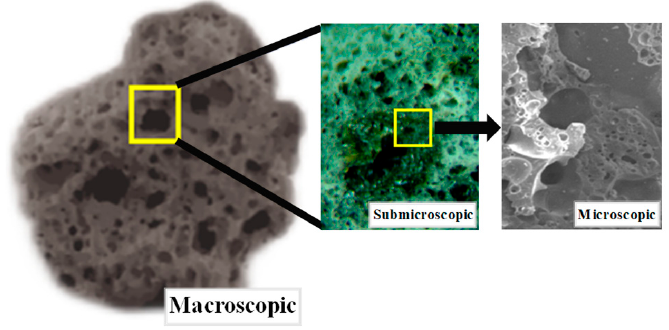
Figure 12. Morphology of LWA.